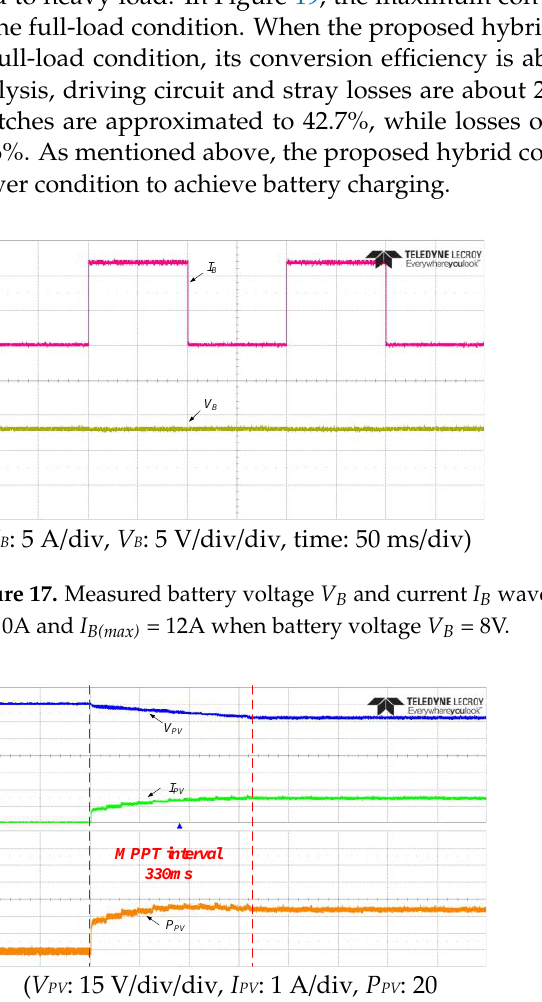
Figure 18. Measured solar voltage V PV , current I PV and power P PV waveforms under the maximum solar power P PV(max) = 50W.